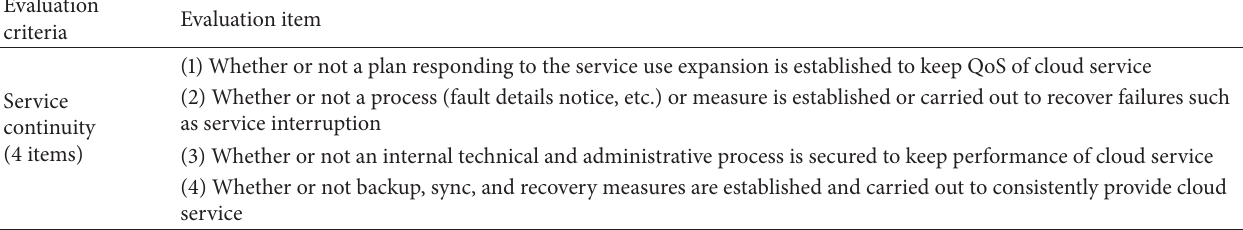
Table 13: Evaluation items of service